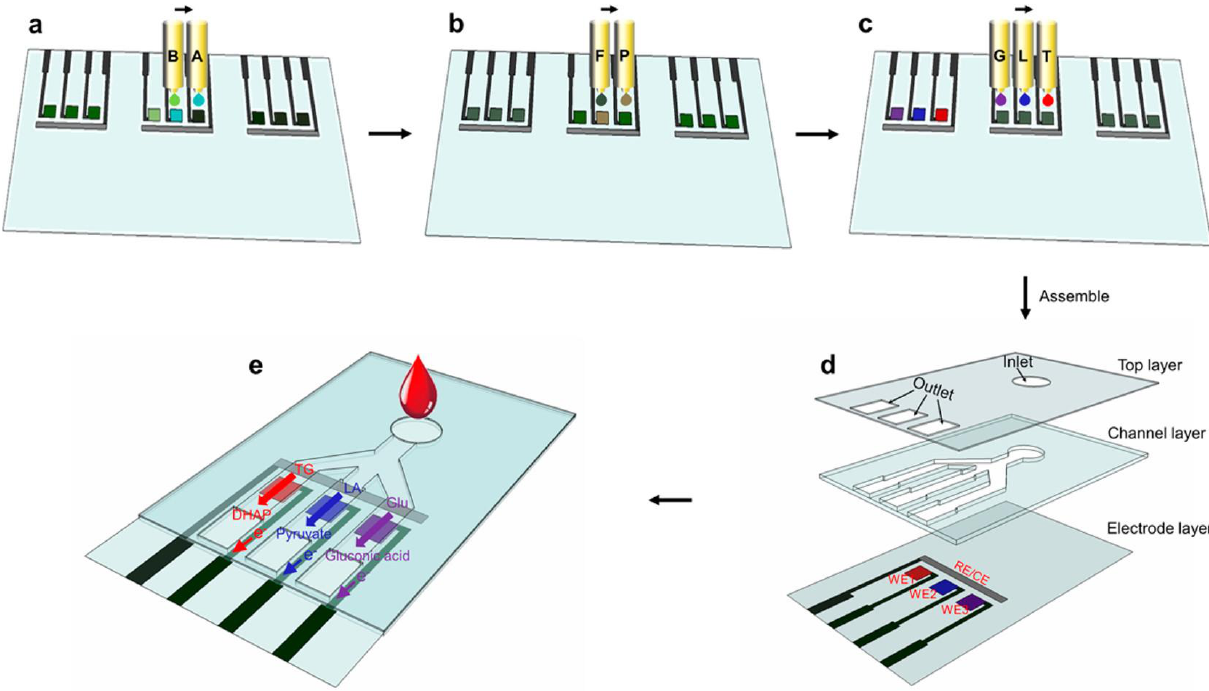
Figure 9. Graphic illustration depicting the fabrication of the inkjet-printed multiplexed biosensor. ( a ) The conductive polymer polyaniline (PAni) hydrogel was formed on the working electrodes (WE) by sequentially printing precursor solutions A (phytic acid and aniline) and B (ammonium persulfate) on the predefined areas. ( b ) Chloroplatinic acid (P) and formic acid (F) solutions were printed on the electrode for homogenous high-density loadings of platinum nanoparticles (PtNPs) on the PAni hydrogel film. ( c ) Enzyme solutions G (glucose oxidase solution, GOx), L (lactic oxidase solution, LOx), and T (mixed solution of l pase/glycerol kinase/L- α -glycerophosphate oxidase, LP/GK/GPO) were sequentially printed onto their designated working electrodes one by one. ( d ) Finally, the multiplexed biosensor was assembled by integrating the top layer, channel layer, and electrode layer. ( e ) Schematic of the multiplexed detection of metabolites in human blood with the multiplex assay. Reprinted with permission from